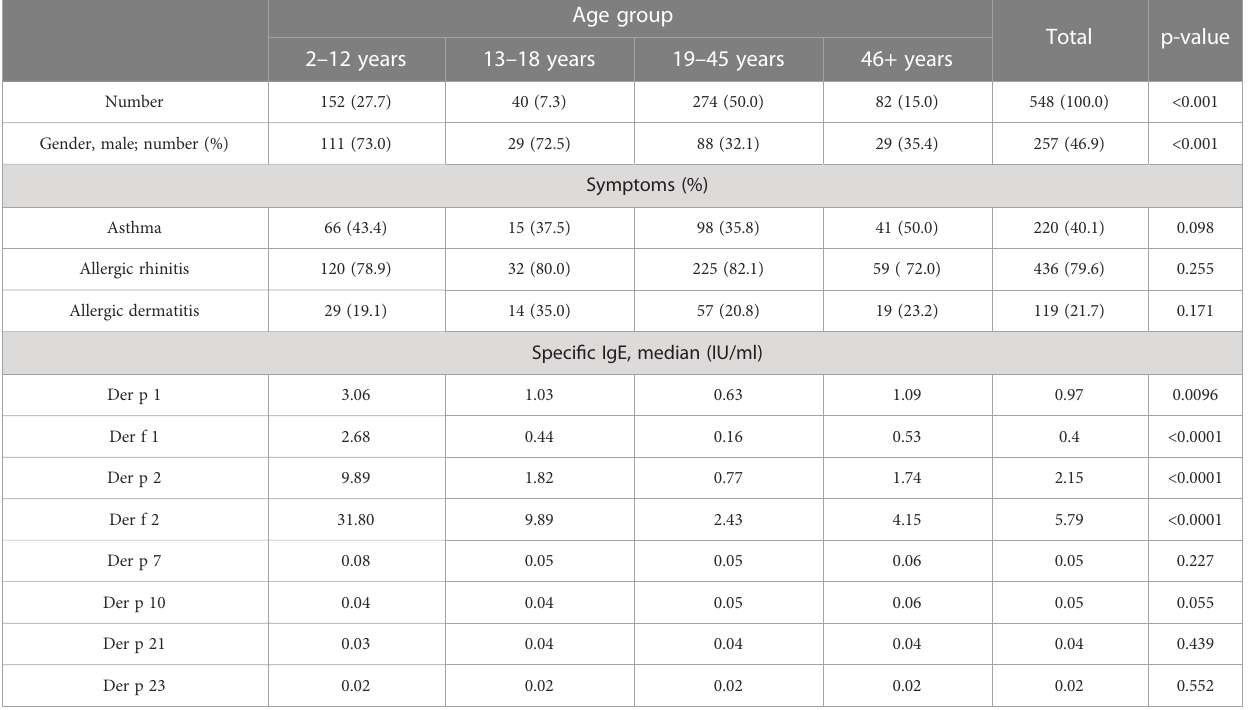
TABLE 1 Demographics and characterization of the study population in the four age